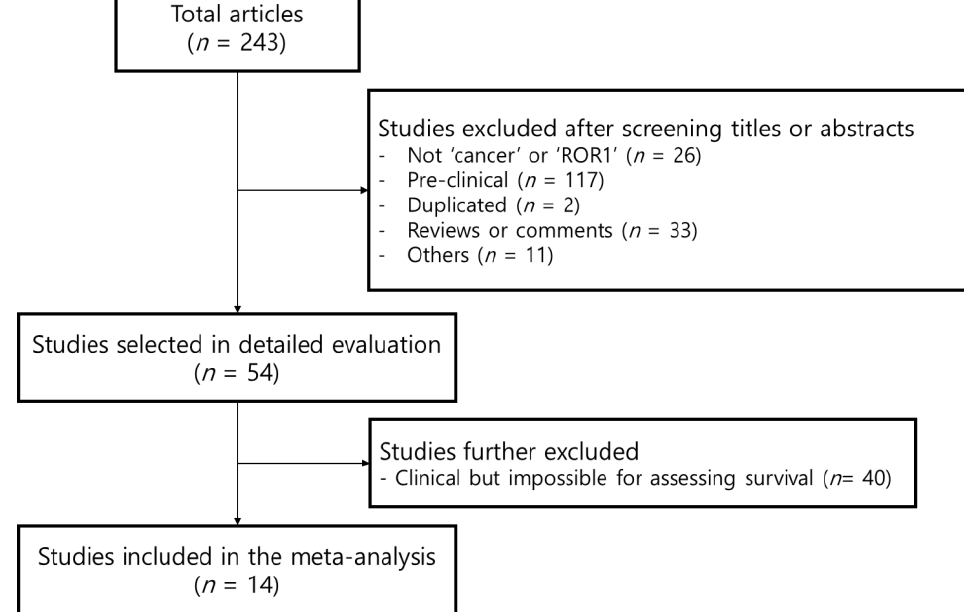
Figure 1. Flowchart for the receptor tyrosine kinase-like orphan receptor 1 (ROR1) data selection.